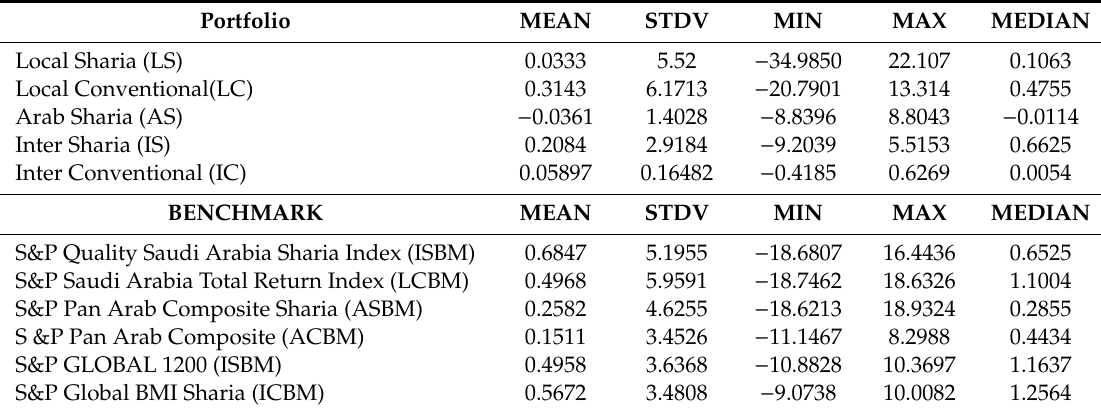
Table 2. Summary statistics on return performance on Islamic and conventional HSBC